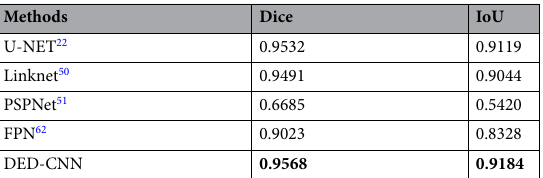
Table 4. Comparision of the proposed method with the other exisiting models in terms of lung segmentation using the SCXR database. The bolded values demonstrate that the proposed method performs better in terms of the metric presented in each column.